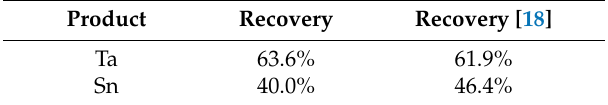
Table 7. Comparison of results of centrifugal separation measured using SQ-XRF.